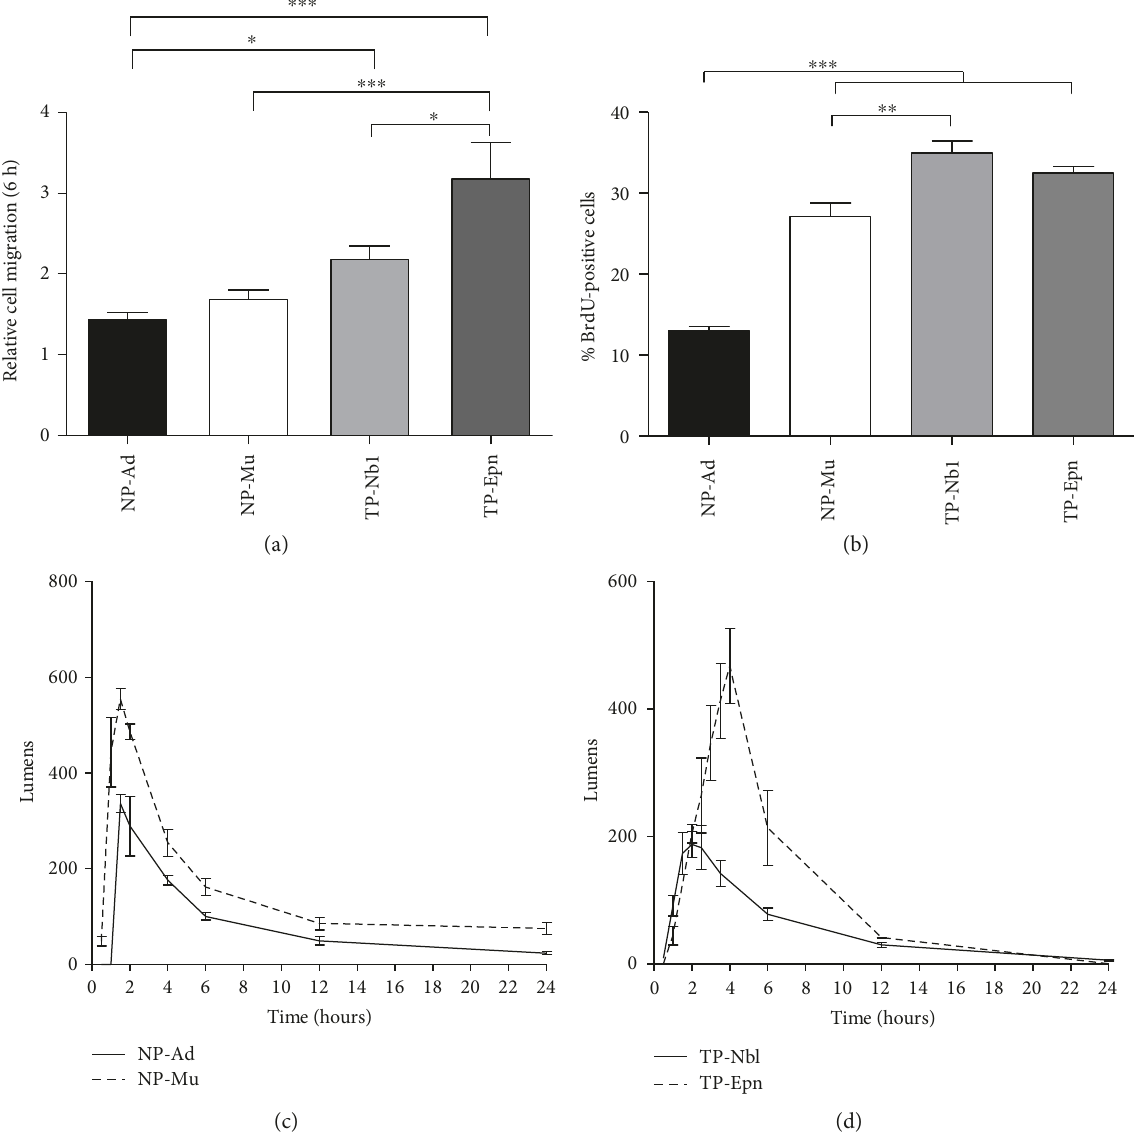
Figure 2: Activated properties of normal and tumor-associated pericytes. (a) Cell migration was calculated after 6 h in the presence of chemical stimulus, relative to basal cell migration without chemotaxis. (b) Cell proliferation based on BrdU incorporation after 24 h in culture. Kinetics of tube-like formation by (c) normal pericytes and (d) tumor-associated pericytes, under angiogenic conditions in vitro. Normal pericyte samples: NP-Ad and NP-Mu. Tumor-associated pericyte samples: TP-Nbl and TP-Epn. Signi fi cance level: ∗ P < 0 05 , ∗∗ P < 0 01 , and ∗∗∗ P < 0 001